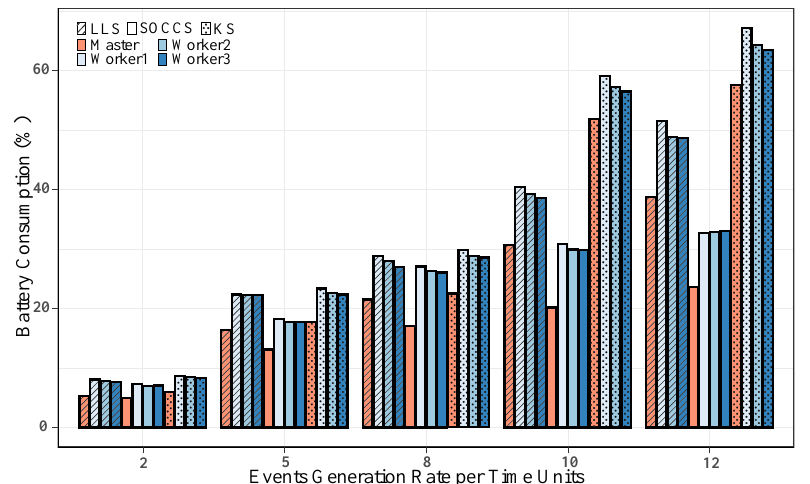
Figure 15. Battery consumption for each node while running different scheduling